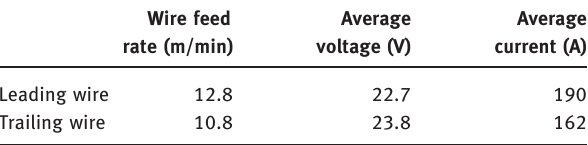
Table 2: Welding process settings and